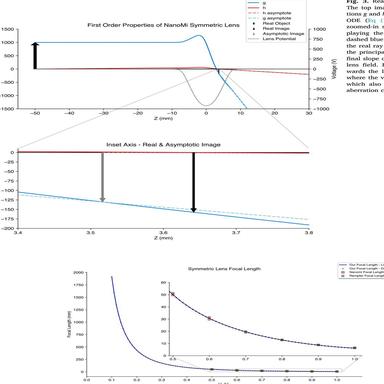
Real & Asymptotic image formation. The top image shows the first-order ray solutions g and h obtained by solving the linearised ODE (. The bottom image shows a zoomed-in section of the image location, displaying the real and asymptotic image. The dashed blue and red lines are the asymptotes of the real ray paths (solid red and blue lines) of the principal rays g and h, obtained from the final slope of each ray, far after it has left the lens field. By tracing an asymptote back towards the lens fr